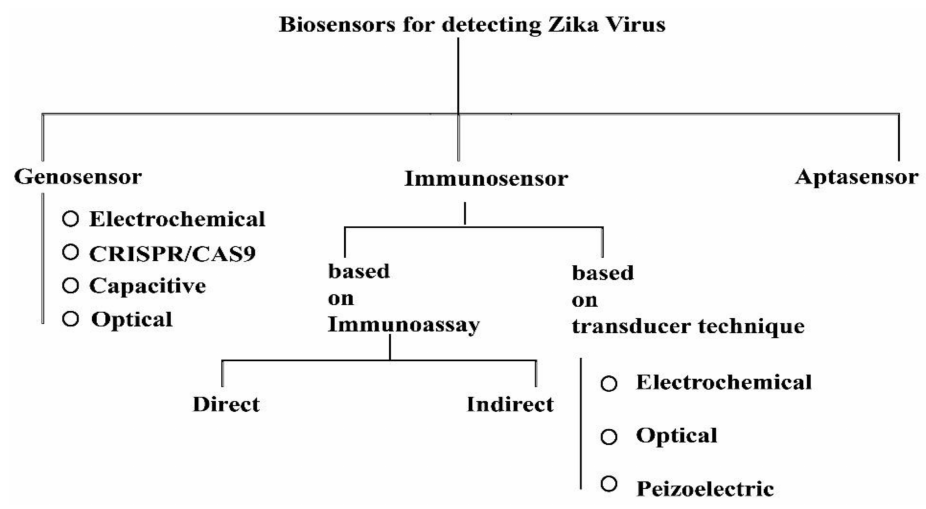
Figure 7. Types of biosensors for detecting Zika virus. This diagram was redrawn from [120]. Devices with genosensors, those that are gene-based, use DNA immobilization tech- niques and different binding methods for, e.g., DNA-RNA, DNA-DNA, and DNA-protein